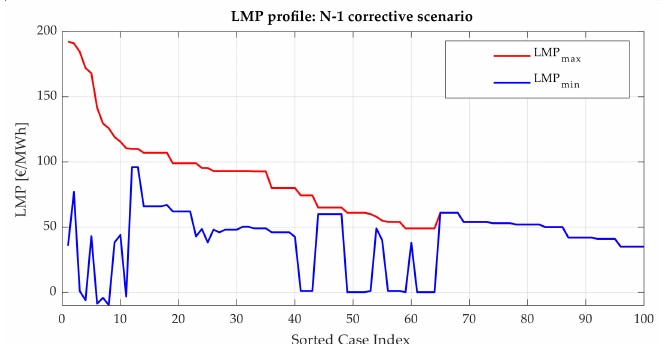
Figure 14. LMP profile over considered case: N1cor scenario.